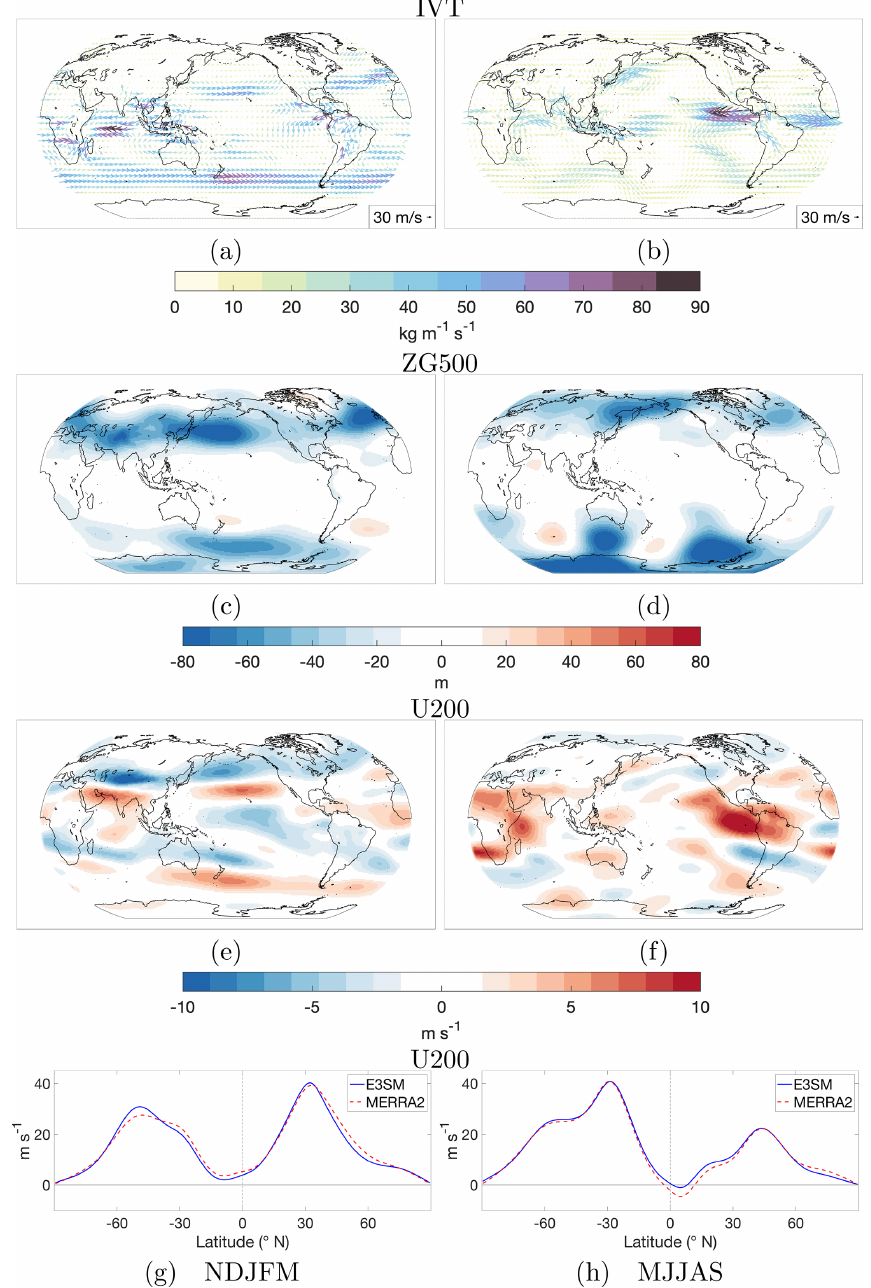
Figure 7. Seasonal differences between E3SM and MERRA2 (a–h) – IVT, geopotential height at 500hPa, zonal wind at 200hPa, and zonal means over the Pacific and Atlantic basins (100–360 ◦ E) of zonal wind at